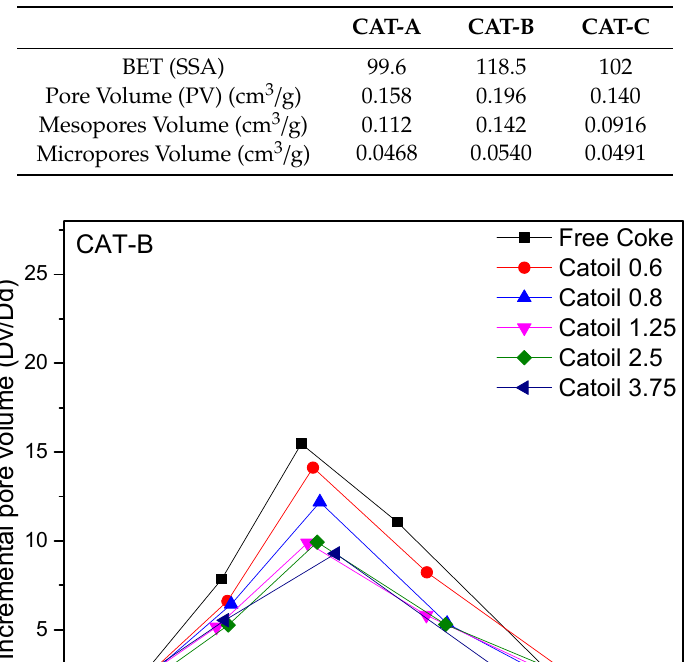
Figure 4. BET-nitrogen adsorption plot. N 2 adsorption-desorption isotherms obtained from different samples of CAT-B after a run at 550 °C and 7 s contact time. Table 4. Specific surface areas and pore volumes of the free of coke catalysts.